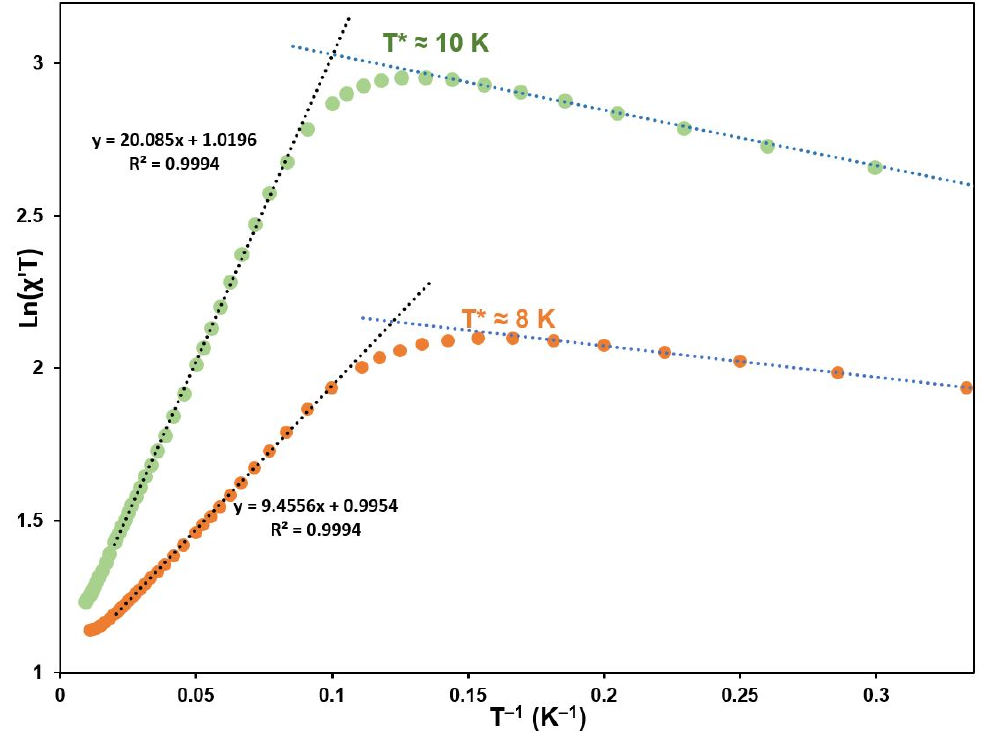
Figure 5. Magnetic dc susceptibility measured at one kOe for 1 (green) and 2 (orange), respectively. Straight dotted lines were fitted (see text). T* represents a crossover temperature.